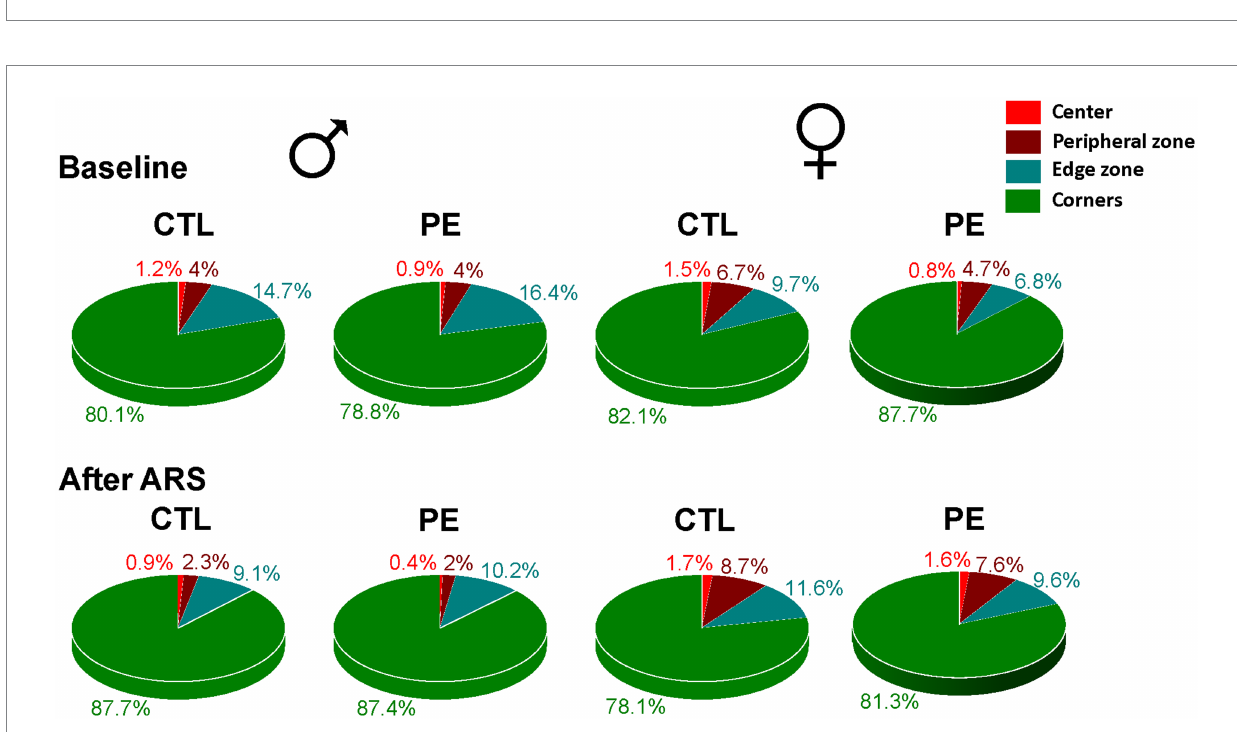
FIGURE 6 Percentages of time spent in the center, peripheral, edge, and corner zone in the OF task. Rats in all group spent >75% of time in the corner zone but <2% in the center